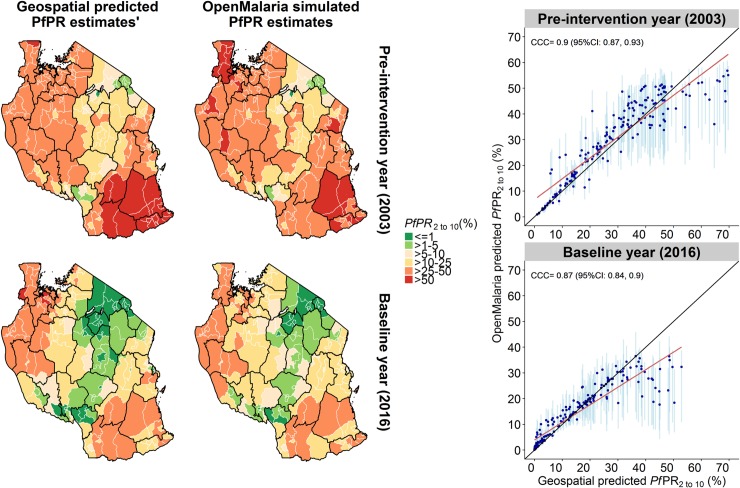
Fitting performance for simulated prevalence per council.The figure shows the predicted prevalence (median) and the geo-statistical model prevalence (mean). The pre-intervention (2003) and baseline year (2016) are the most relevant historical time points since the prevalence before the deployment of interventions determines the level of possible rebound, and the prevalence in the baseline year is used as a comparator for assessing the relative impact of future interventions. The scatter plots (right) shows the respective prevalence estimates (points), with the regression line (red line), and perfect correspondence line (black line). CCC = Lin’s concordance correlation coefficients [78].